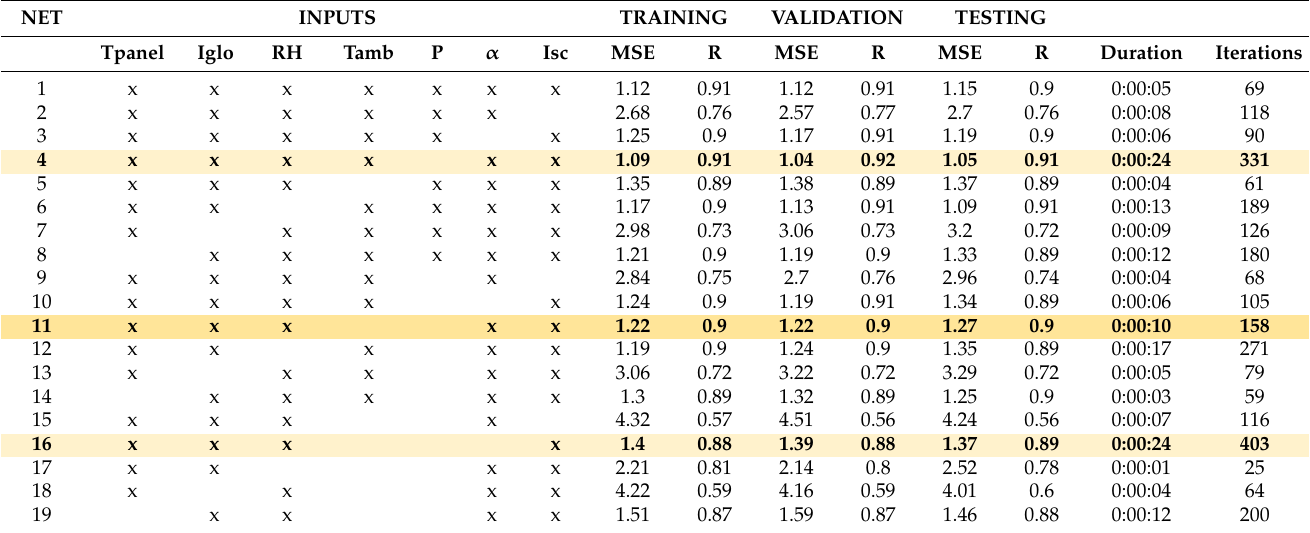
Table 5. ANN Model 2 results with 10